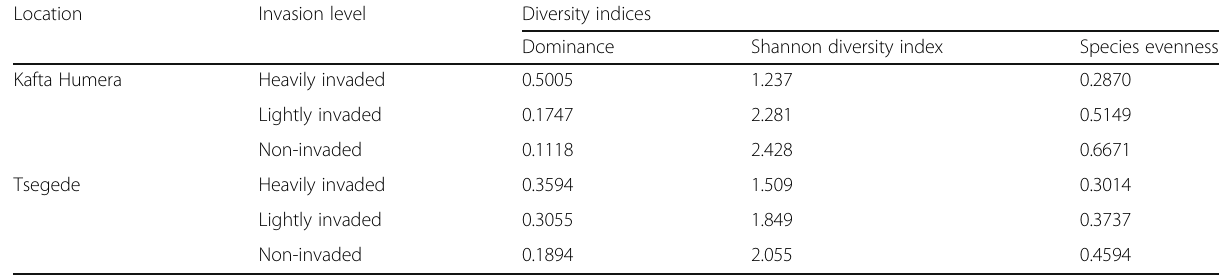
Table 3 Effects of Senna obtusifolia (L.) on species evenness ( E ), Shannon diversity index ( H ), and dominance ( D ) under three invasion levels (non-invaded, lightly invaded, and heavily invaded) at two locations in northern Ethiopia